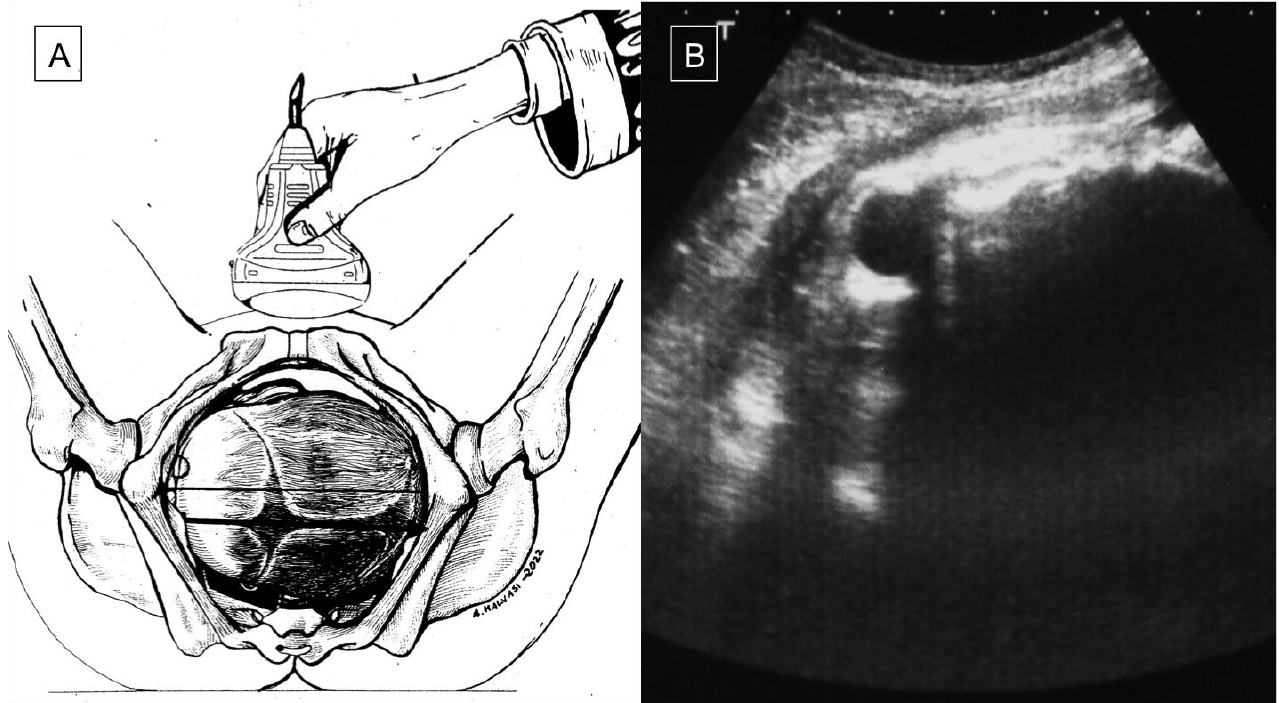
Figure 3. ( A , B ) Suprapubic transabdominal ultrasound exam during labor dystocia: a transverse section of the fetal head through a probe oriented transversely on the lower abdomen allows detecting the fetal head attitude; the midline is perpendicular to the maternal pelvis sagittal plane in a transverse occiput position ( A ), whereas the midline appears shifted down and the anterior or right parietal bone is predominant with respect to the contralateral bone on the transverse scan; thus, the anterior or right orbit is visible as an “anterior squint sign”, which leads to a diagnosis of left transverse occiput position plus anterior asynclitism ( B ).